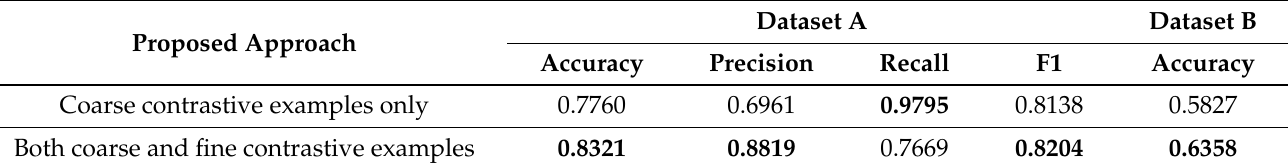
Table 3. The ablation study of how the proposed contrastive examples contribute to the final pose grading performance of the proposed approach. The best performance is indicated by the bold